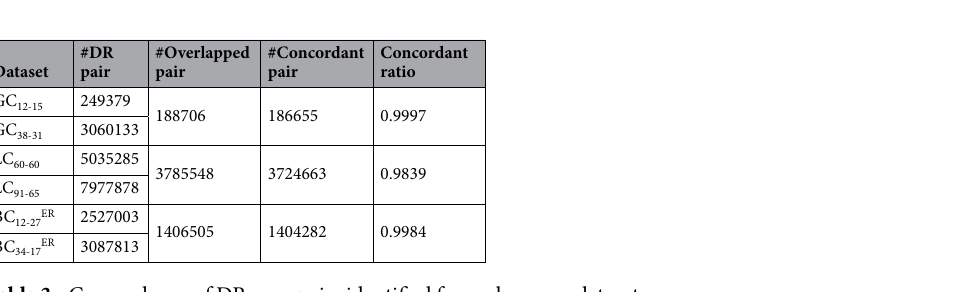
Table 3. Concordance of DR gene pairs identified for each cancer